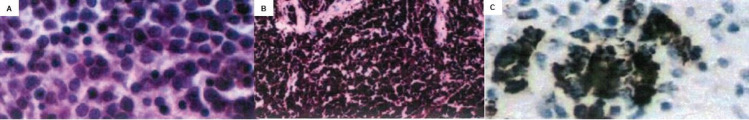
Anatomopathological and immunohistochemical findings. (A): Hematoxylin and eosin stains show neoplasm with a biphasic pattern characterised by pseudoglandular hyperchromatic cells associated with dense fibrovascular stroma. (B): Synaptophysin was positive in immunohistochemistry. (C): Focal Positivity for gp100 Antigen in Immunohistochemistry.